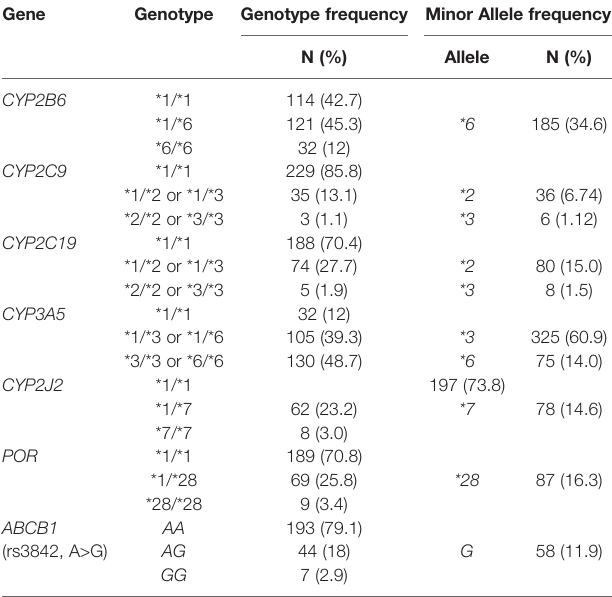
TABLE 2 | Genotype and allele frequency distribution of candidate genes relevant to CPA activation or transport.